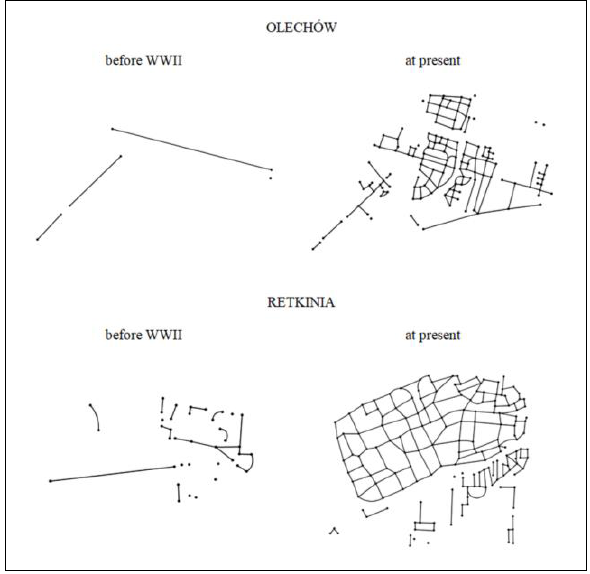
Fig. 8. Graphs depicting the high rank of morphological changes of the former villages Olechów and Retkinia (in the intra-urban area) (Source: own work)